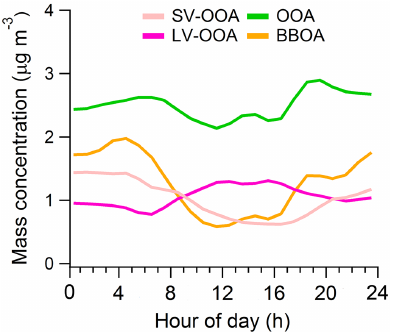
Fig. 9. Diurnal profiles of SV-OOA (WS), LV-OOA (WS), BBOA (DS) and OOA